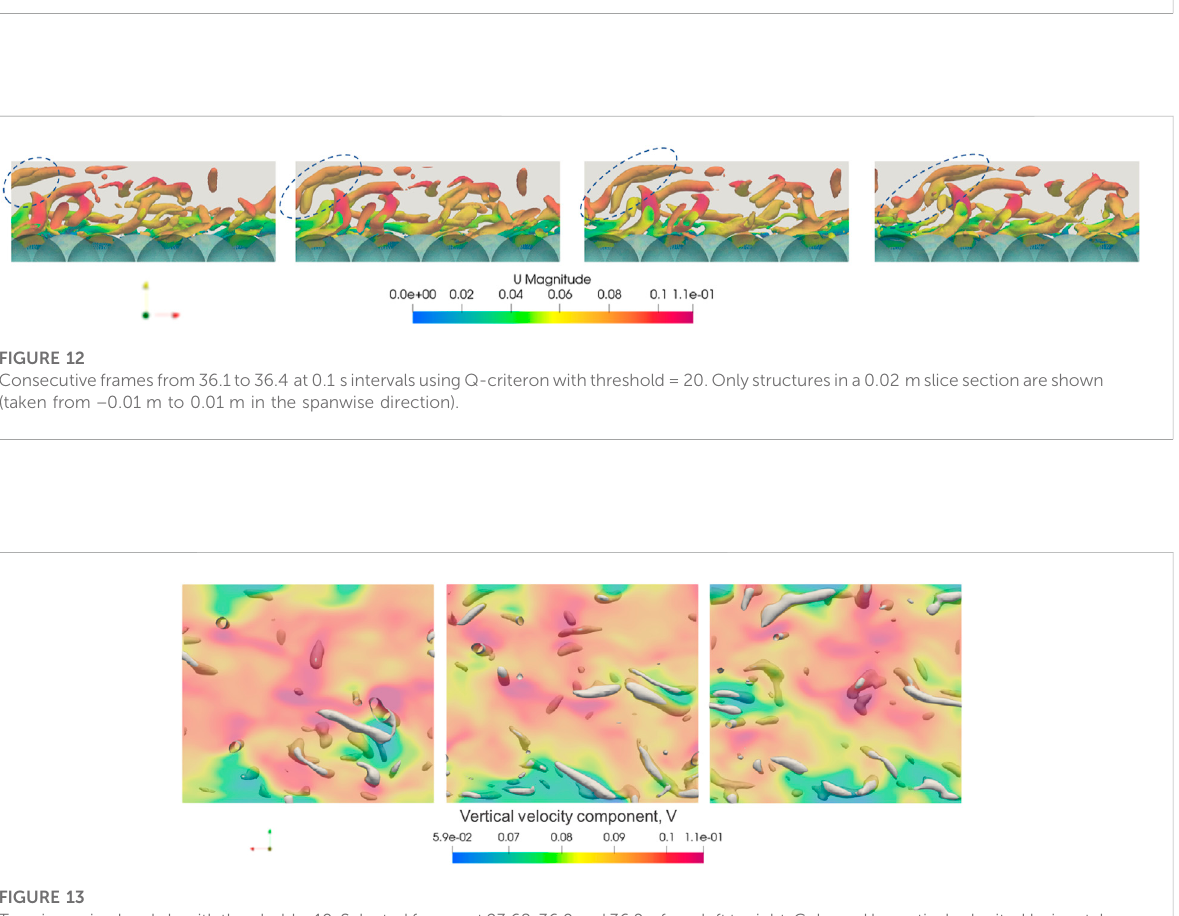
FIGURE 11 Vortex Detection methods at 89.54 s. (A) Q-criterion method with threshold = 40 (B) Lambda2 method with a threshold = 50.